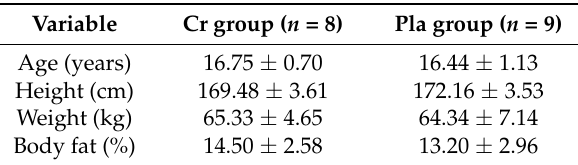
Table 1. Subject